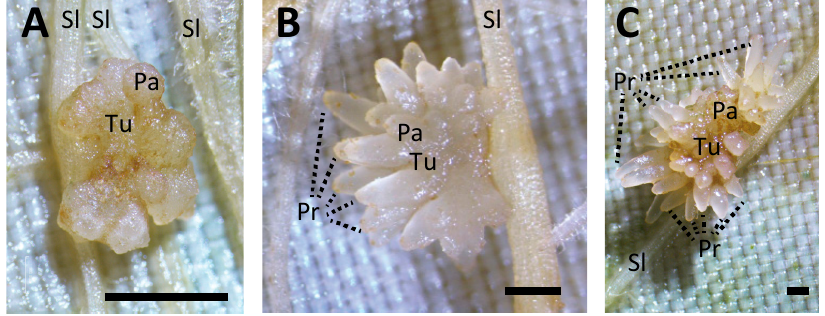
Figure 1. Appearance of Phelipanche aegyptiaca tubercles at different parasitic stages. The tubercle diameters are ( A ) 1.5 mm, ( B ) 3 mm, and ( C ) 1 cm. Scale bar: 1 mm. Tu, tubercle; Pr, protrusion; Sl, tomato; Pa, P. aegyptiaca .